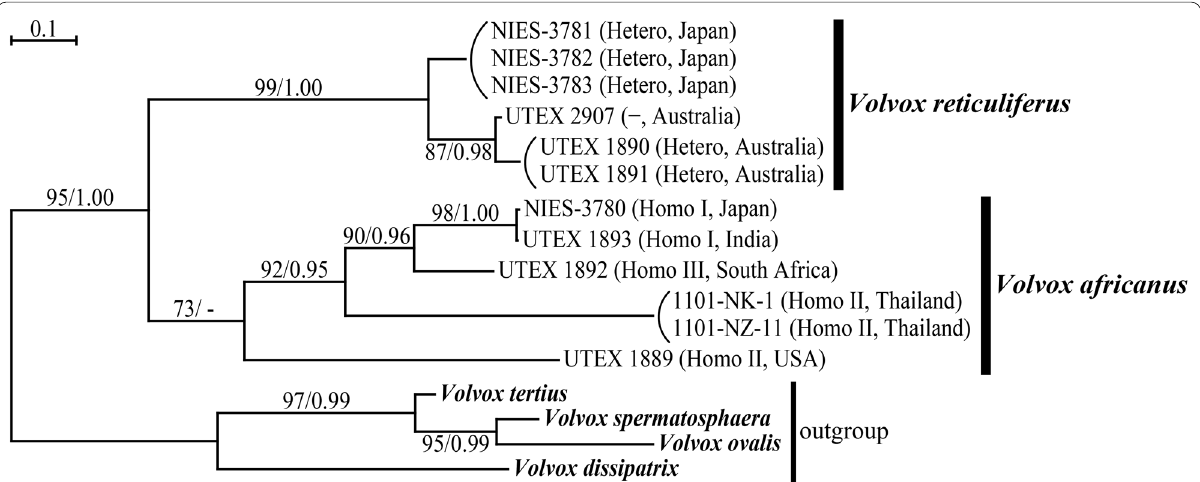
Fig. 5 Phylogenetic relationships of four types of mating systems (Table 1) of Volvox africanus (homothallic) and V . reticuliferus (heterothallic), as inferred from internal transcribed spacer region 2 of nuclear ribosomal DNA. UTEX 2907 originating from Australia (https:// utex. org/) lacks information of sexual reproduction (Nozaki et al. 2015a), but it was classified as V. reticuliferus based on vegetative morphology and phylogeny (Nozaki et al. 2015a). The tree was constructed by ML method (based on T92 G model). The alignment is available in TreeBASE (Vos et al. 2010, + 2012; ID 28191). Branch lengths are proportional to the genetic distances, which are indicated by the scale bar above the tree. Numbers on the left or right side at the branches represent bootstrap values ( 50%, based on 1000 replicates) obtained with the ML analysis or posterior probabilities ≥ ( 0.95) of Bayesian inference, ≥